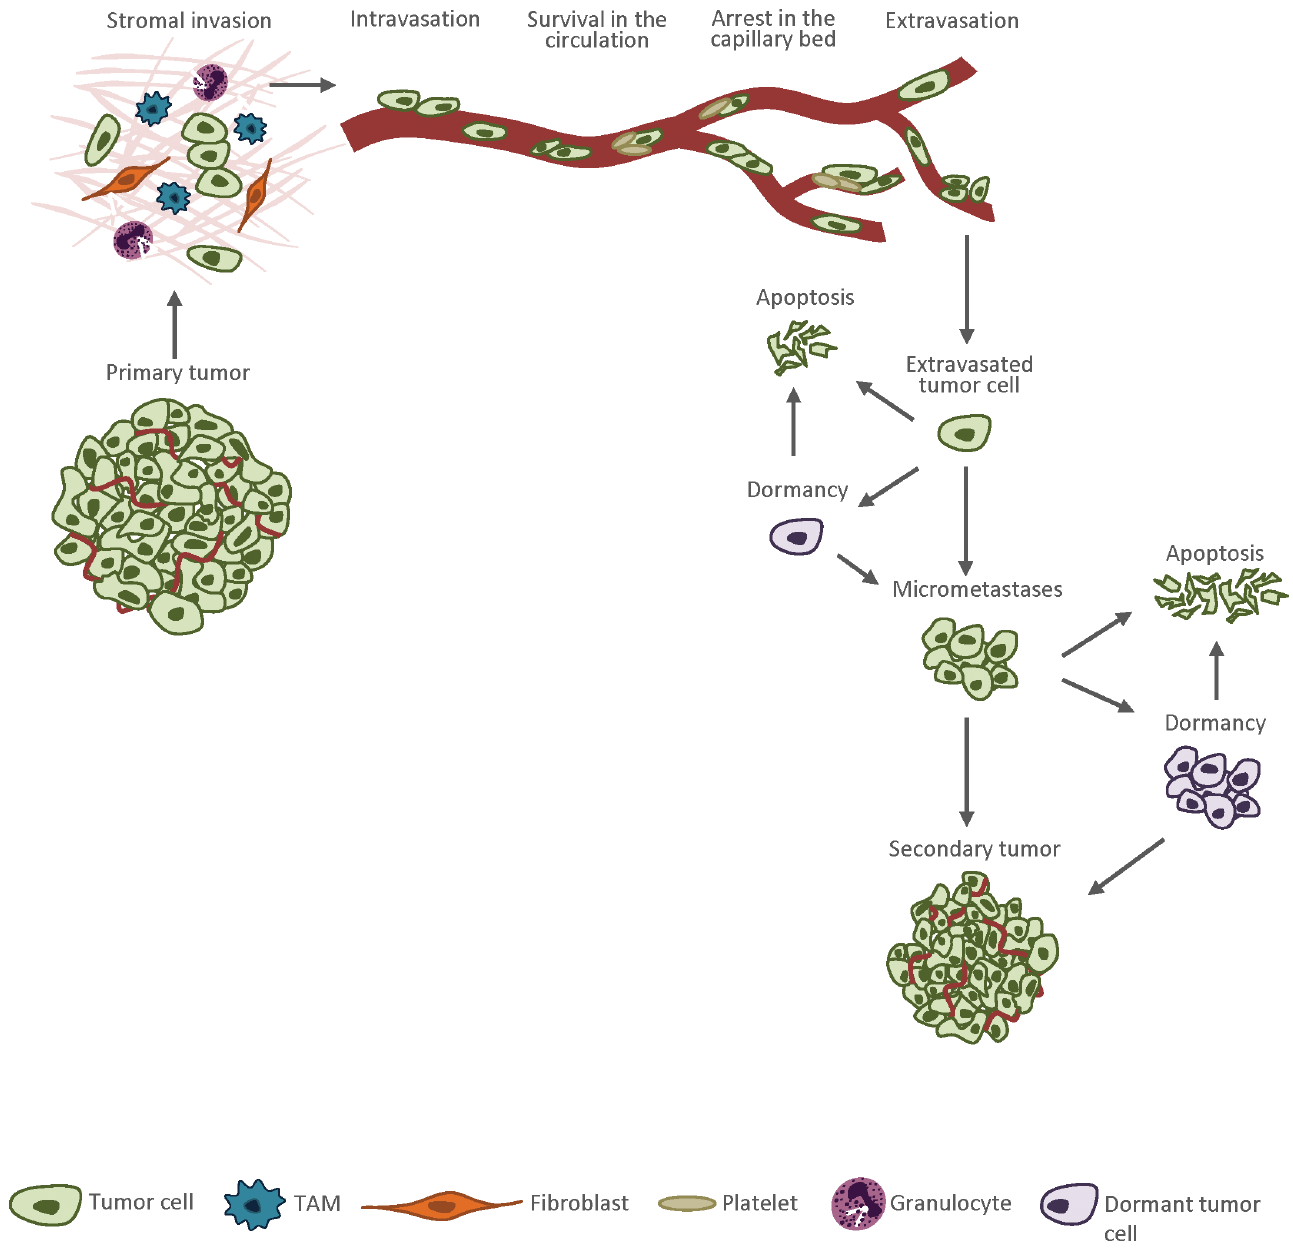
Figure 1. The metastatic cascade. Tumor cells that acquired an invasive phenotype detach from the primary lesion, invade the